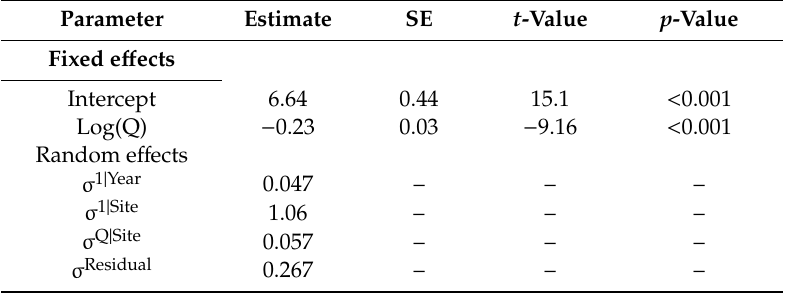
Table 4. Parameter estimates for the best supported model predicting log[x]-transformed total dissolved solids in the Monongahela River.